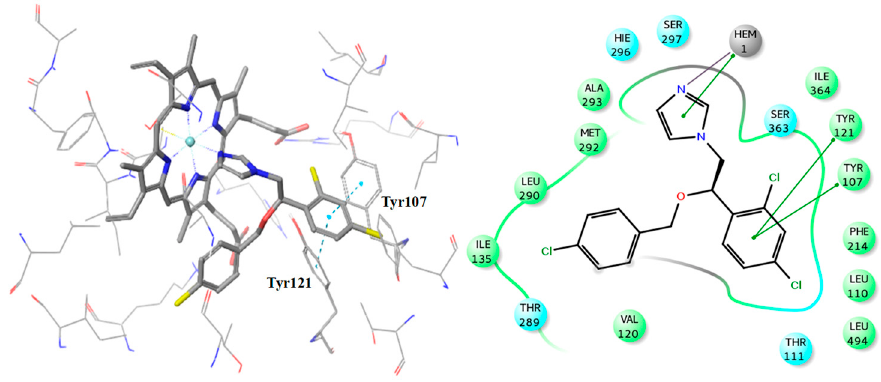
Figure 9. Binding pose of R-econazole with the corresponding 2D ligand interaction diagram.